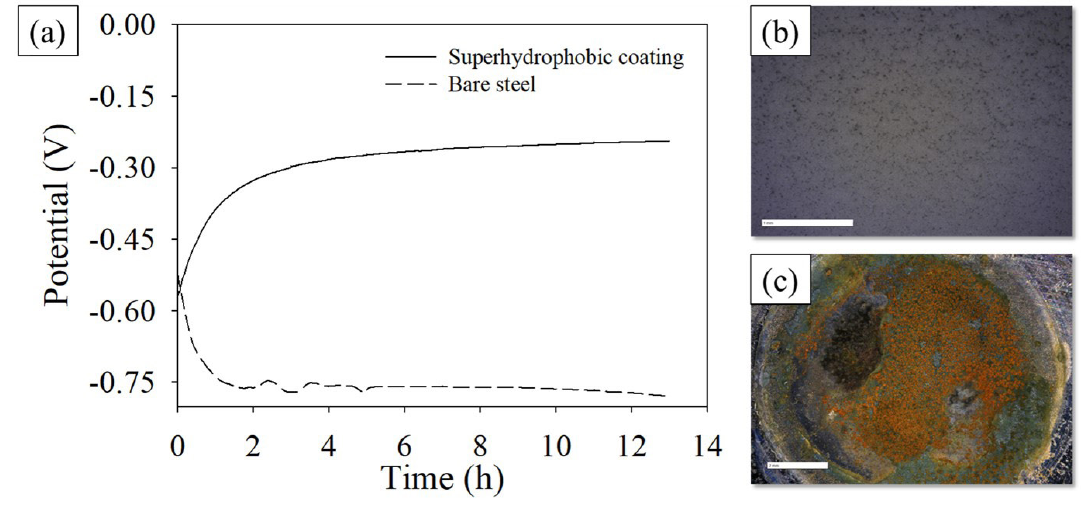
Figure 6. (a) potential monitoring throughout 13 hours of immersion in NaCl 3.5% wt. for coated and uncoated carbon steel, and optical microscopy of (b) coated and (c) uncoated carbon steel after immersion.